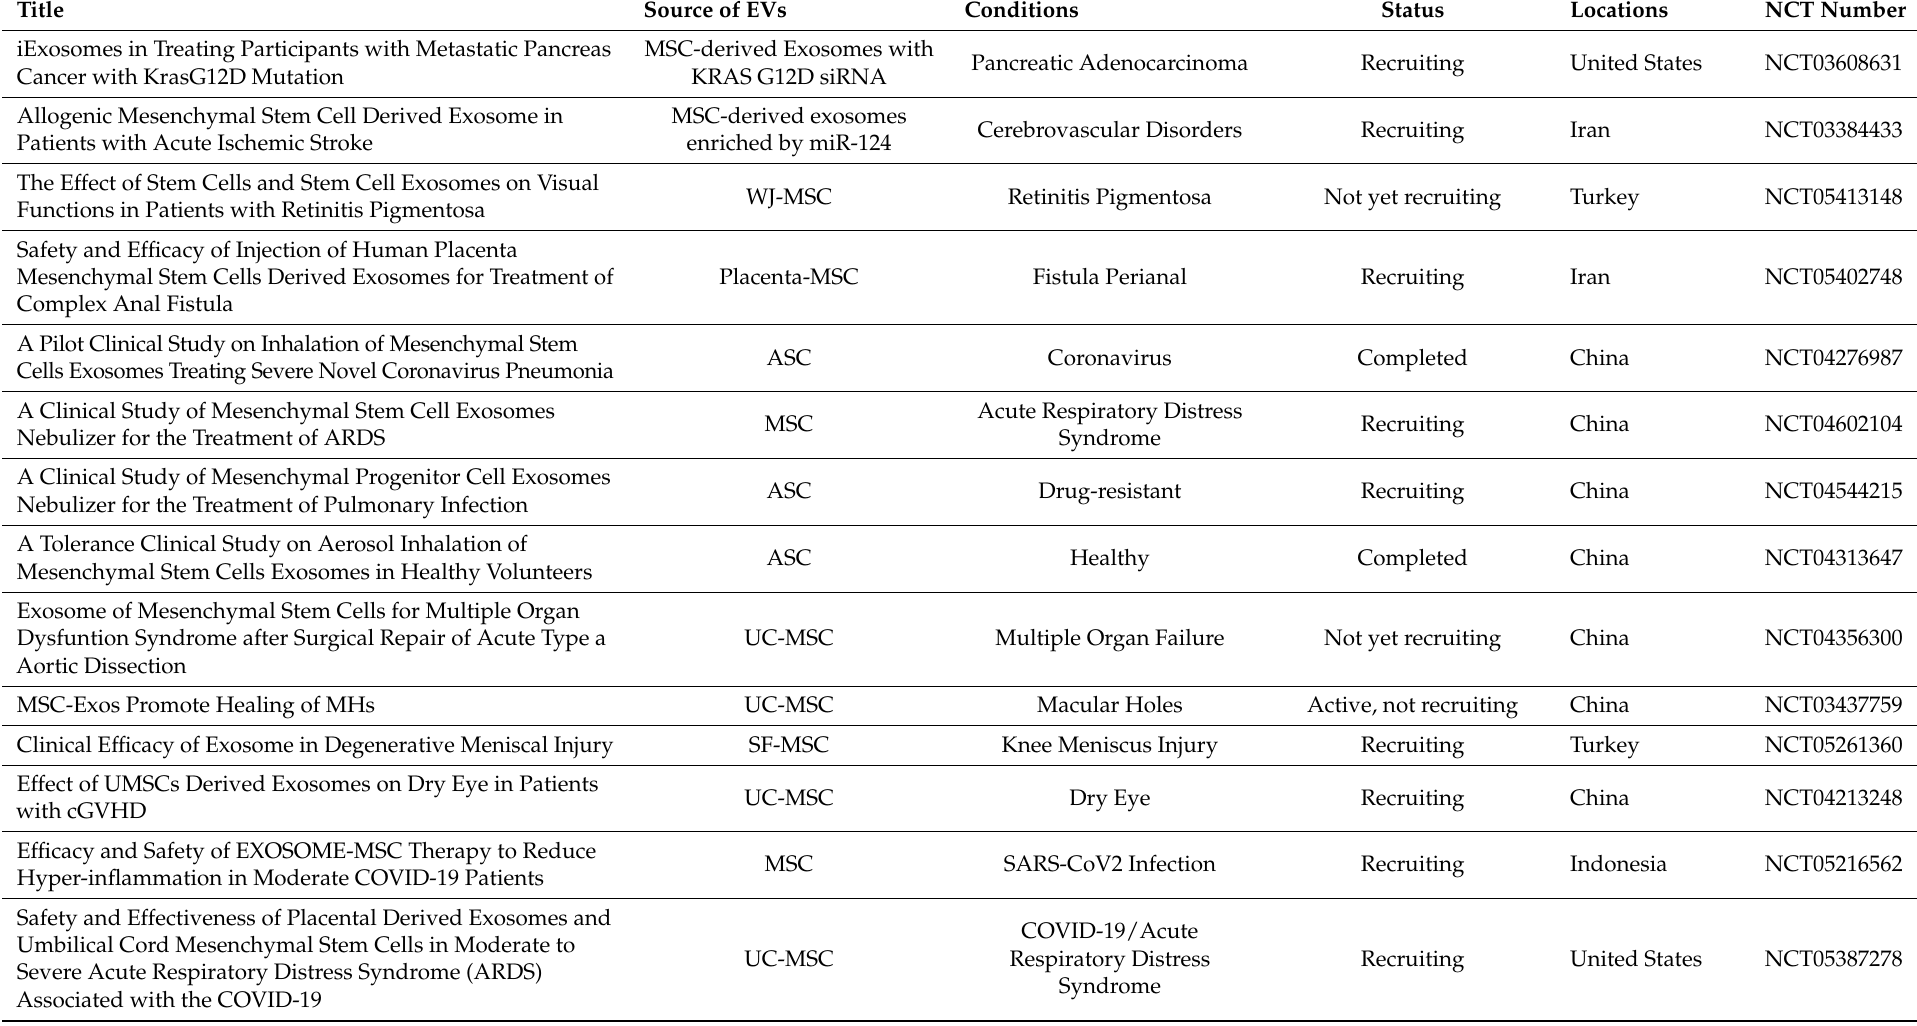
Table 1. Ongoing clinical trials using